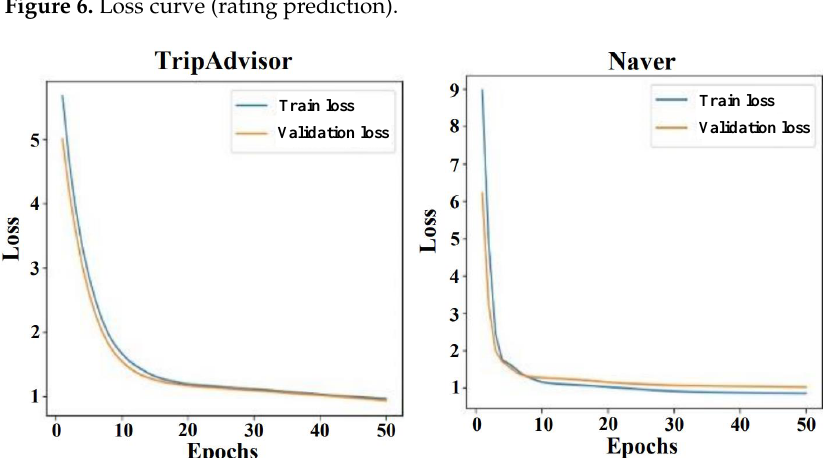
Figure 7. Loss curve (diversity